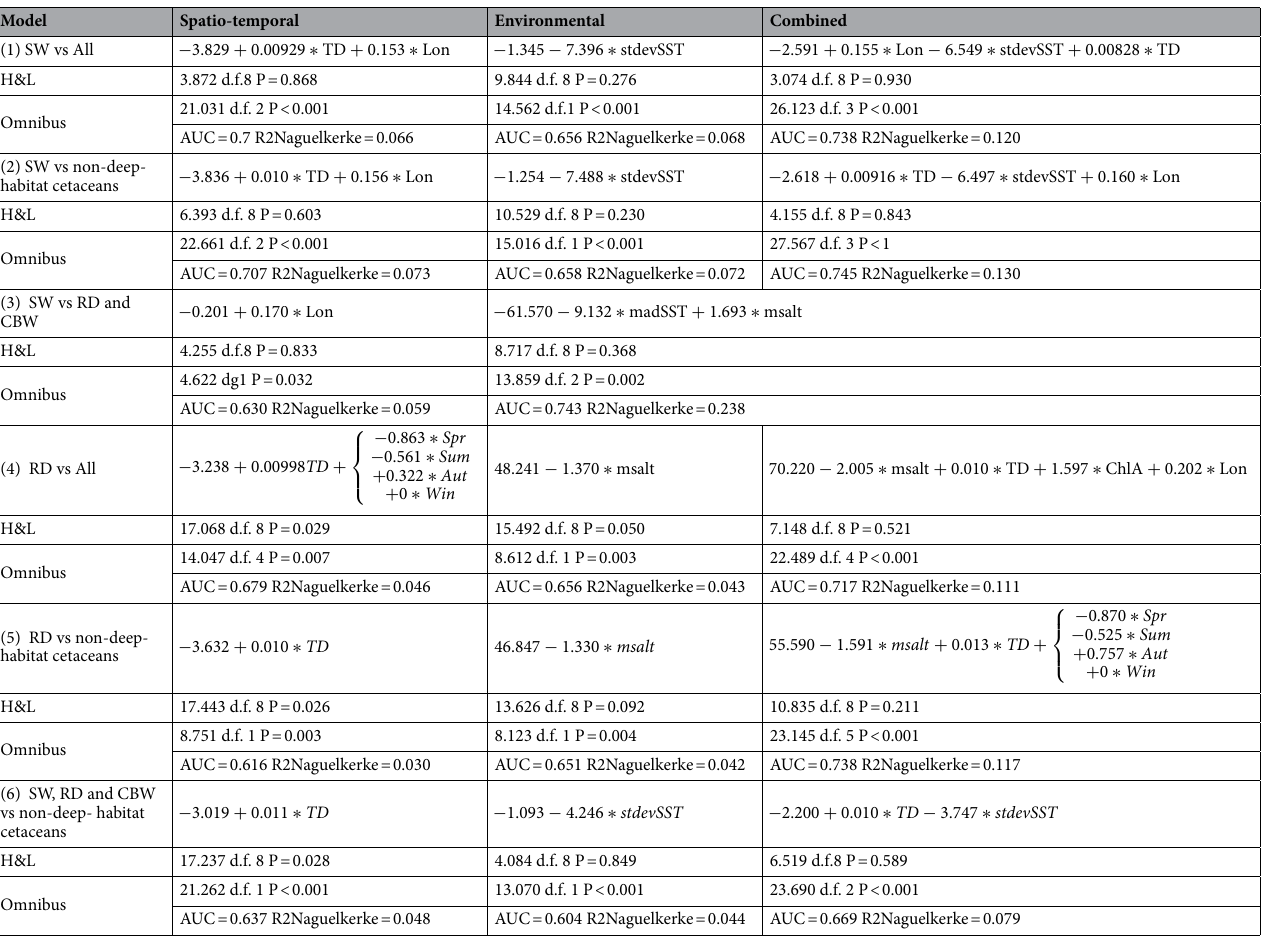
Table 1. Significant differential distribution models and their performance